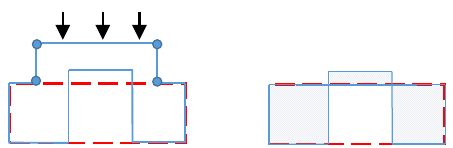
Figure 1. Self-intersection of a building model caused by the Shortest Edge First transformation strategy (blue – initial LOD, red – target LOD).